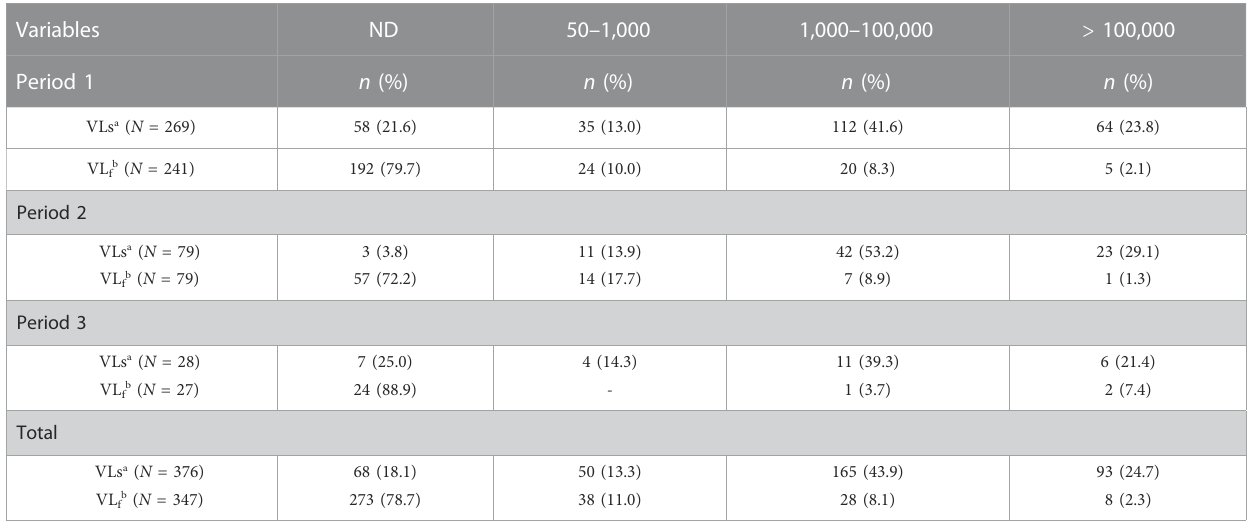
TABLE 3 Initial and fi nal viral load range of people living with HIV included in the study for the periods assessed, Hospital Universitário de Brasilia, Brasilia, Brazil, 2019. Variables ND 50 – 1,000 Period 1